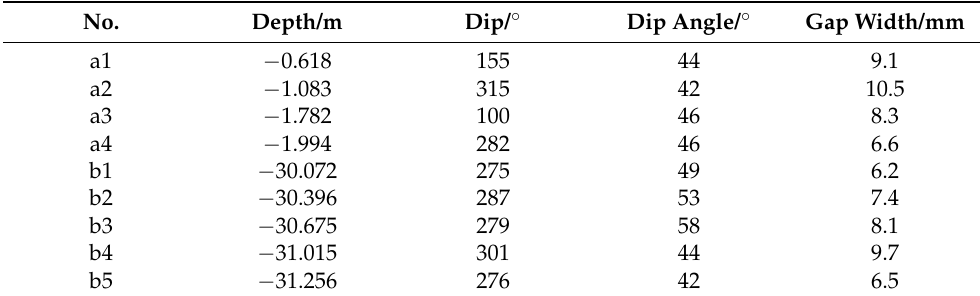
Table 1. The automatic data generated for the structural planes of Figure